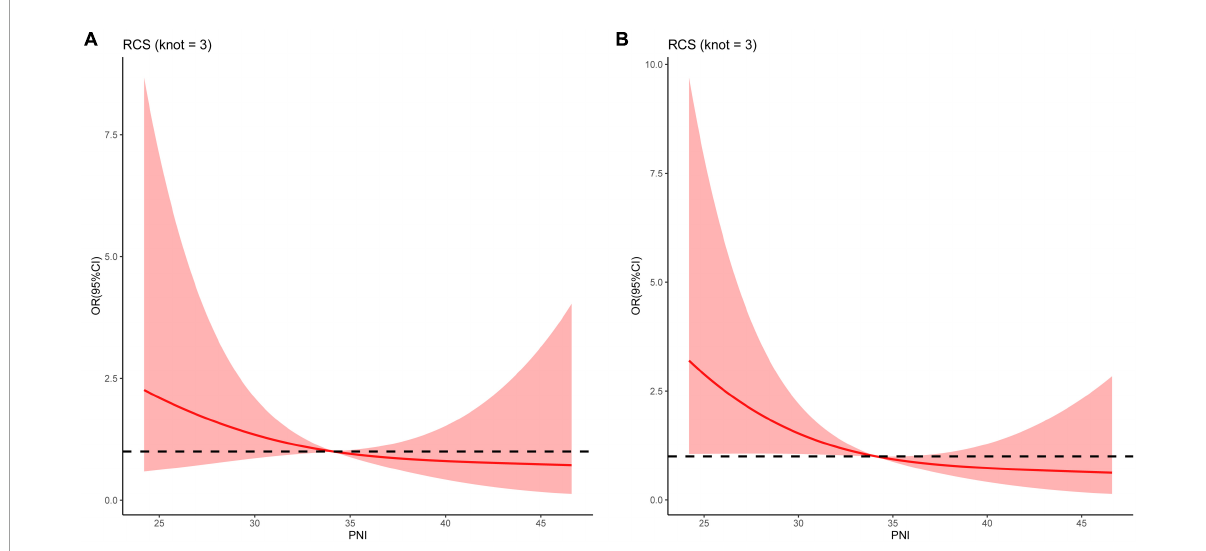
FIGURE3 Restricted cubic spline curves for the relationships between the prognostic nutritional index and the risk of death at (A) 3, and (B) 6 months in patients with decompensated liver